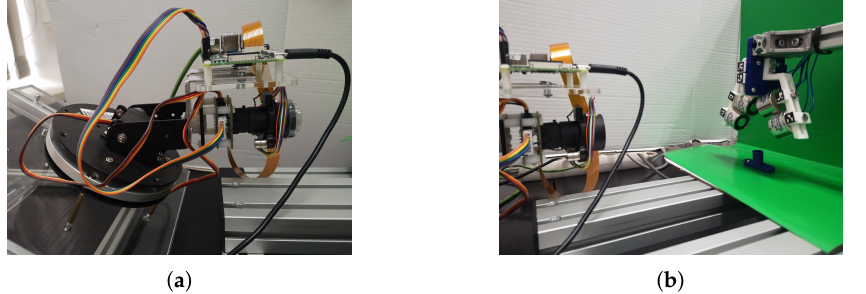
Figure 11. Camera system. Pan–tilt–zoom camera system mount ( a ). The view of the gripper framework ( b